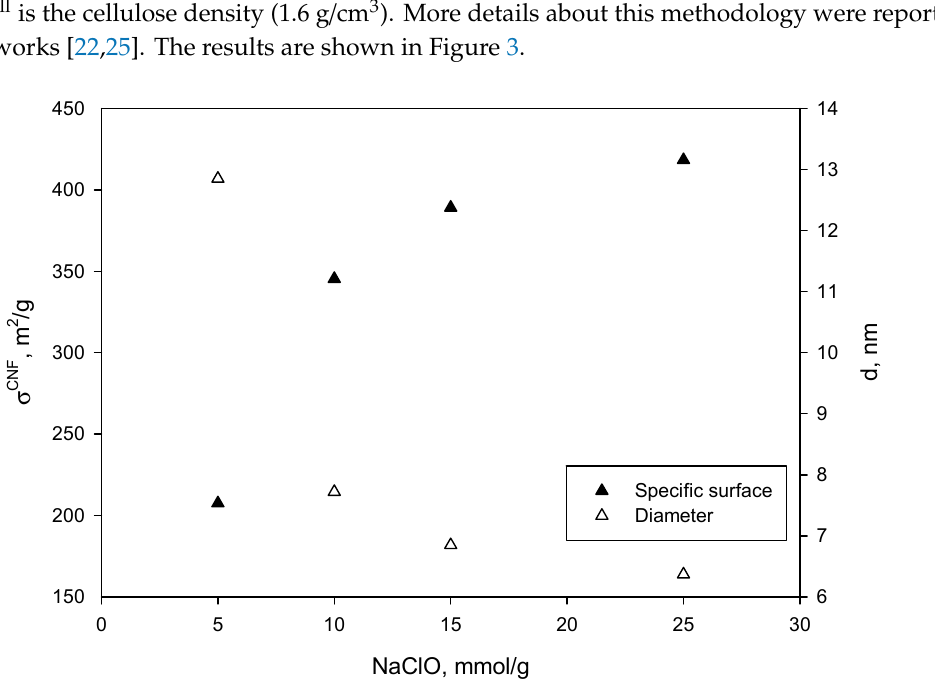
Figure 3. Evolution of the specific surface (black, left vertical axis) and the fiber diameter (white, right vertical axis) with increasing amounts of NaClO.